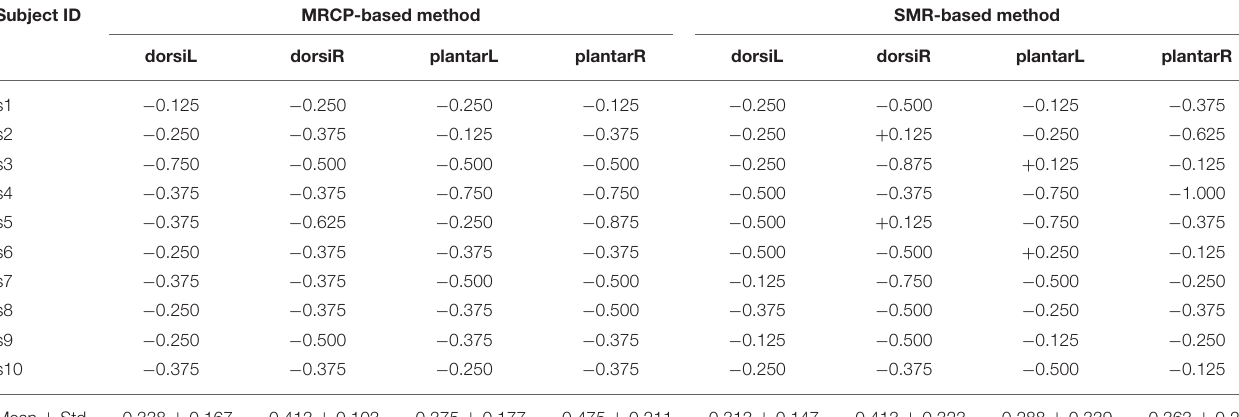
TABLE 1 | Single-trial detection performance (latency) for each subject with different influence factors. Subject ID MRCP-based method SMR-based method dorsiL dorsiR plantarL plantarR dorsiL dorsiR